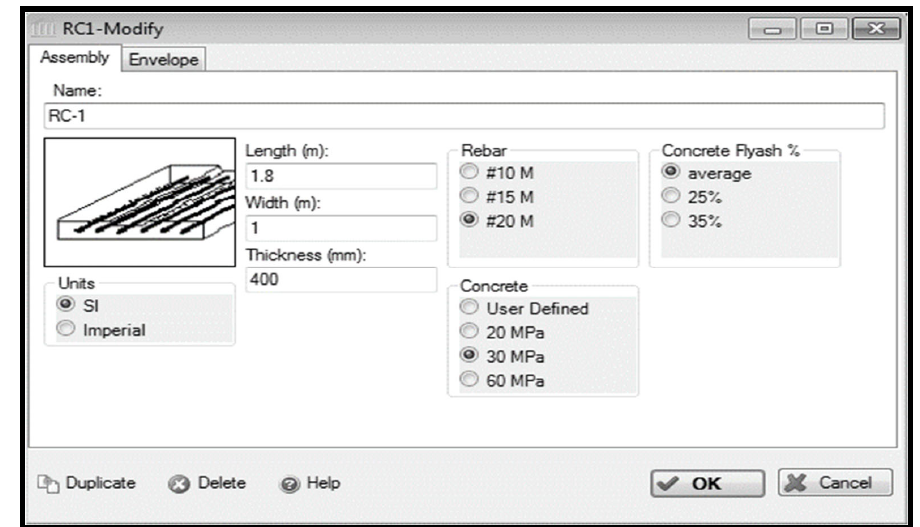
Fig. 3. Interface of Athena Impact